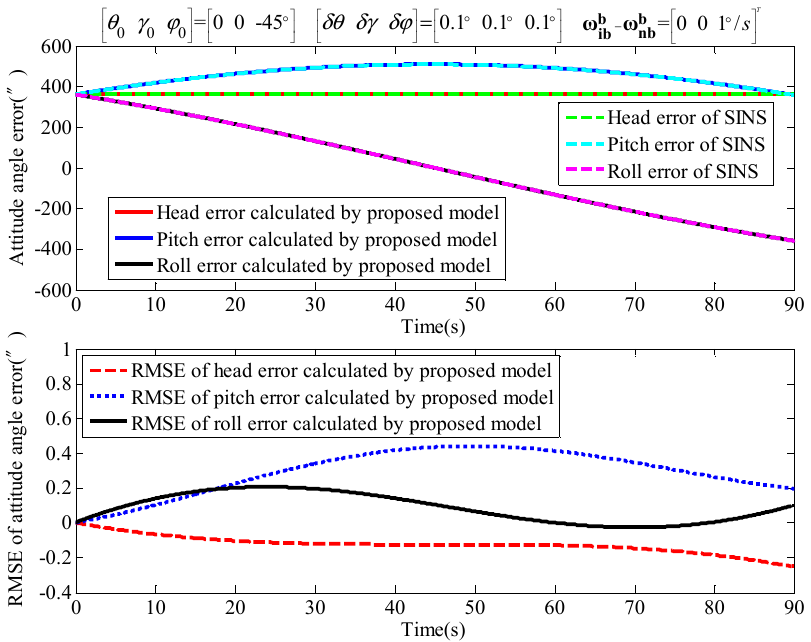
Figure 9. The Euler angle error propagation with coupling of three initial Euler angle errors and rotation in the Y axis. Appl. Sci. 2018 , 8 , 74